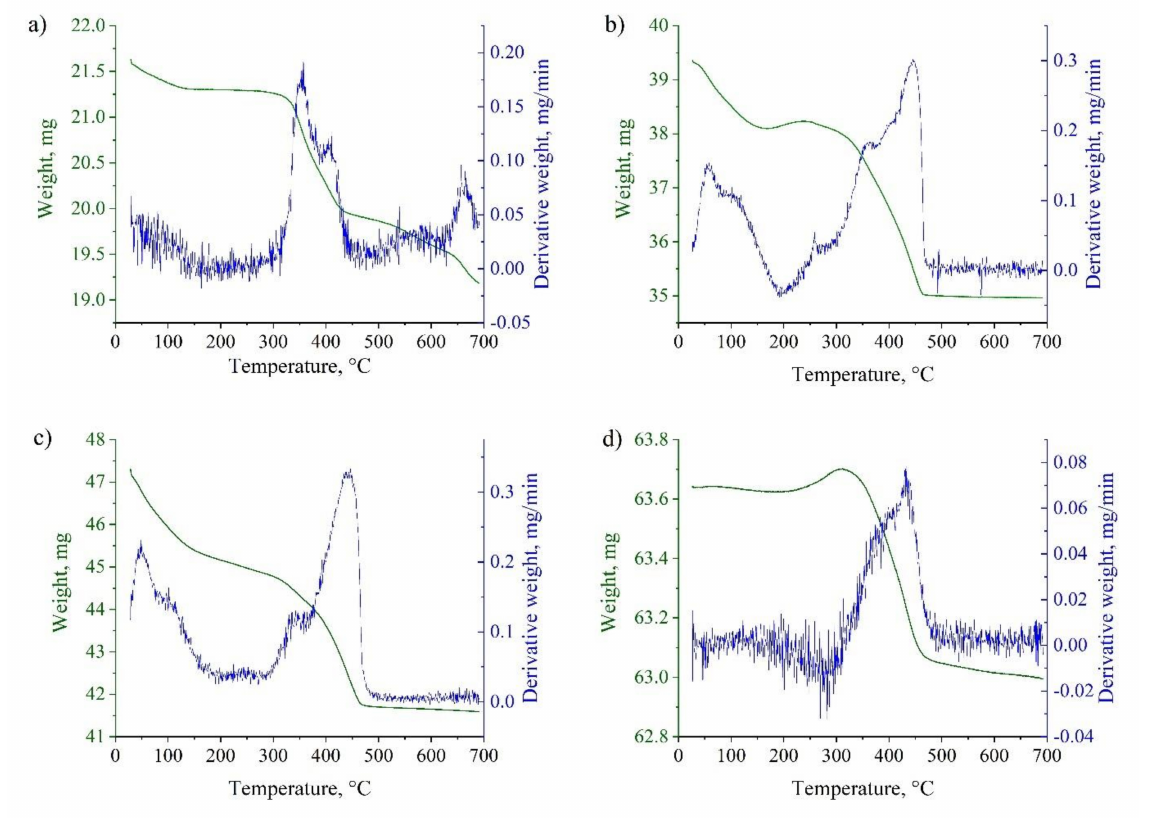
Figure 7. TGA curves for samples reduction in a hydrogen atmosphere: Fe(n–FeOOH) ( a ); Fe(n–Fe 2 O 3 _01) ( b ); Fe(n–FeO_02) ( c ); m–Fe_01 ( d